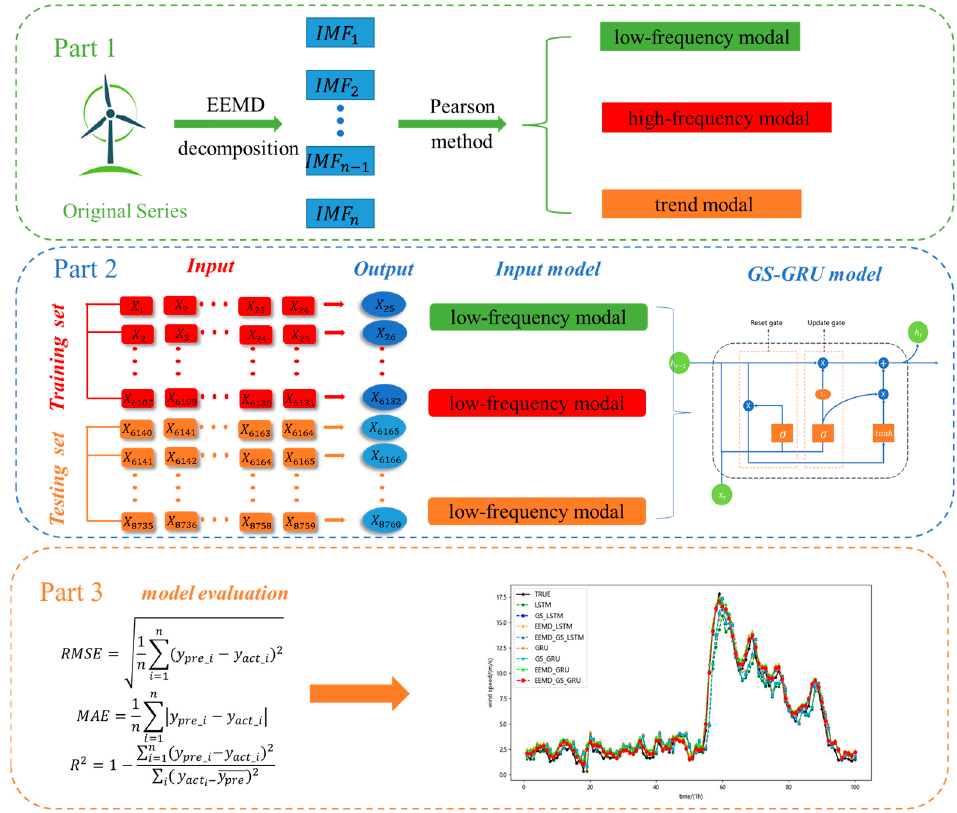
Figure 4. EMMD-GS-GRU forecasting process.